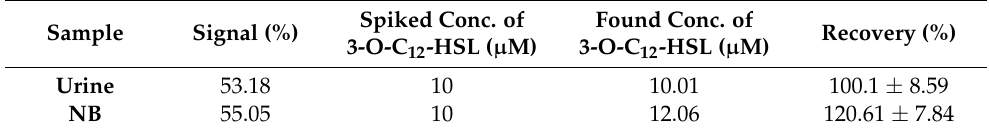
Table 5. Real analysis of samples spiked with 10 µ M 3-O-C 12